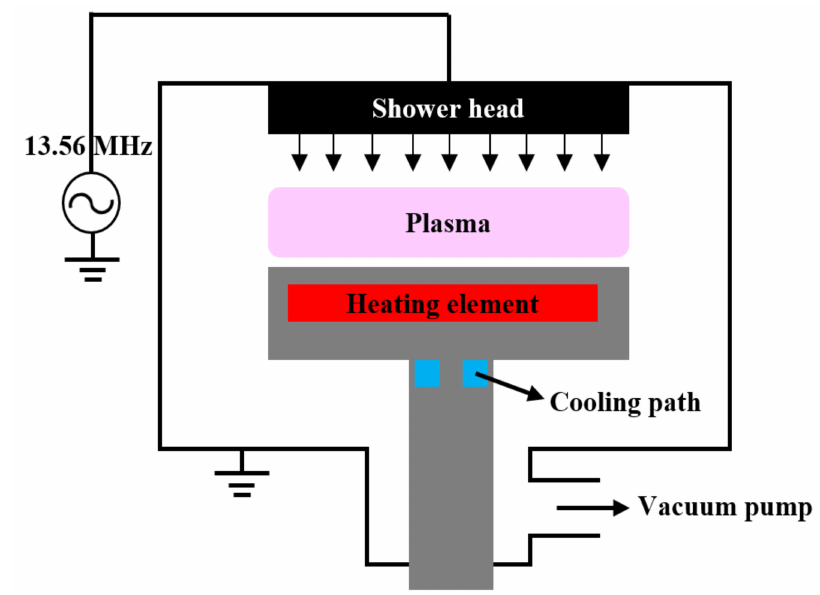
Figure 1. Schematic of the PECVD equipment.